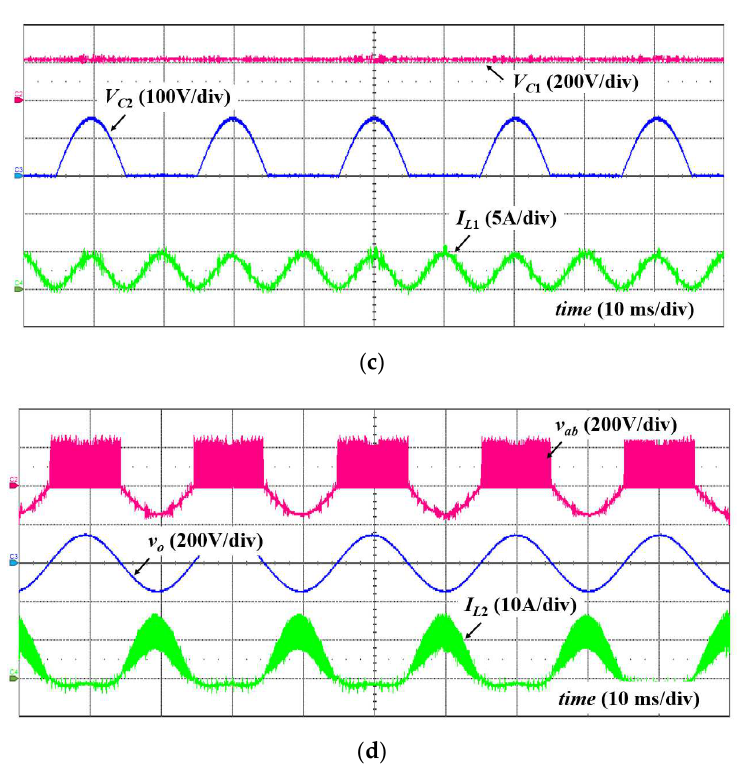
Figure 9. Experimental results with V in = 220 V. ( a ) Diode D 1 and switch S 1 voltage. ( b ) Switches S 2 , S 3 , S 4 voltage. ( c ) Capacitors C 1 , C 2 voltage, and inductor L 1 current. ( d ) inverter output voltage v ab , load voltage v o , and inductor L 2 current.